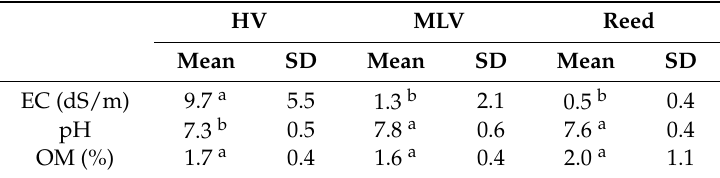
Table 2. Environmental conditions of sample points according to the vegetation types. Means with different superscript letters indicate significant difference between vegetation types ( p < 0.05). (Mean: Arithmetic mean, SD: Standard deviation) HV MLV Reed